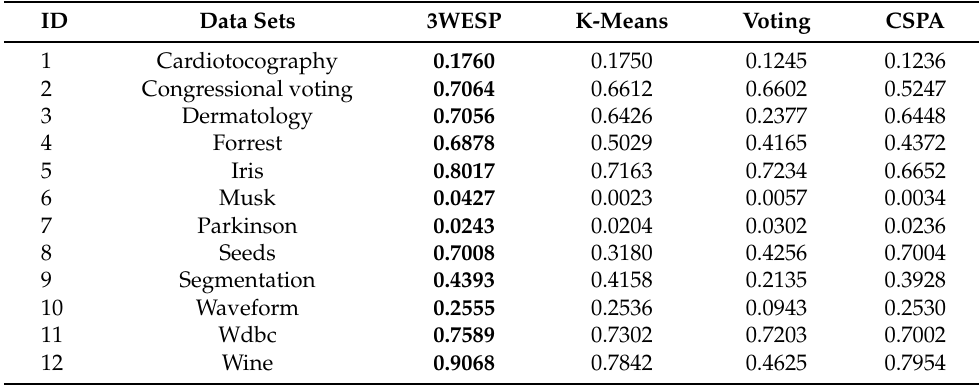
Table 3. Experimental results of ARI on UCI data